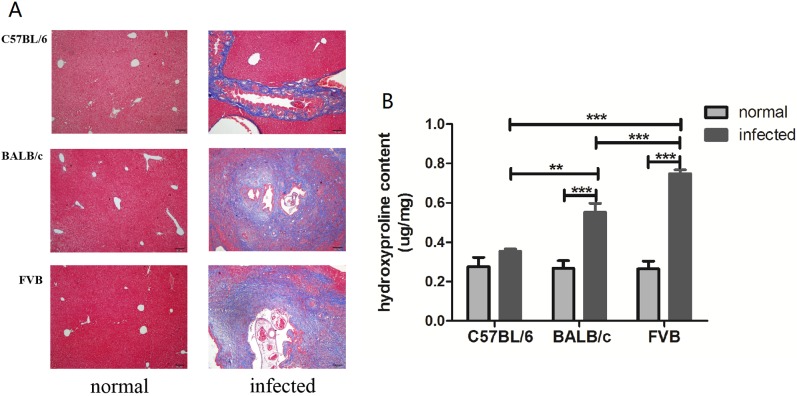
Determination of hepatic fibrosis in normal and Clonorchis sinensis infected mice.(A) Paraffin-embedded sections were stained by Masson’s trichrome and the blue area represents collagen deposition. (B) The concentration of the hydroxyproline content was tested in liver homogenate in three strains. Each value represents the mean±SEM of four or more independent experiments. ** = P <0.01, *** = P <0.001.